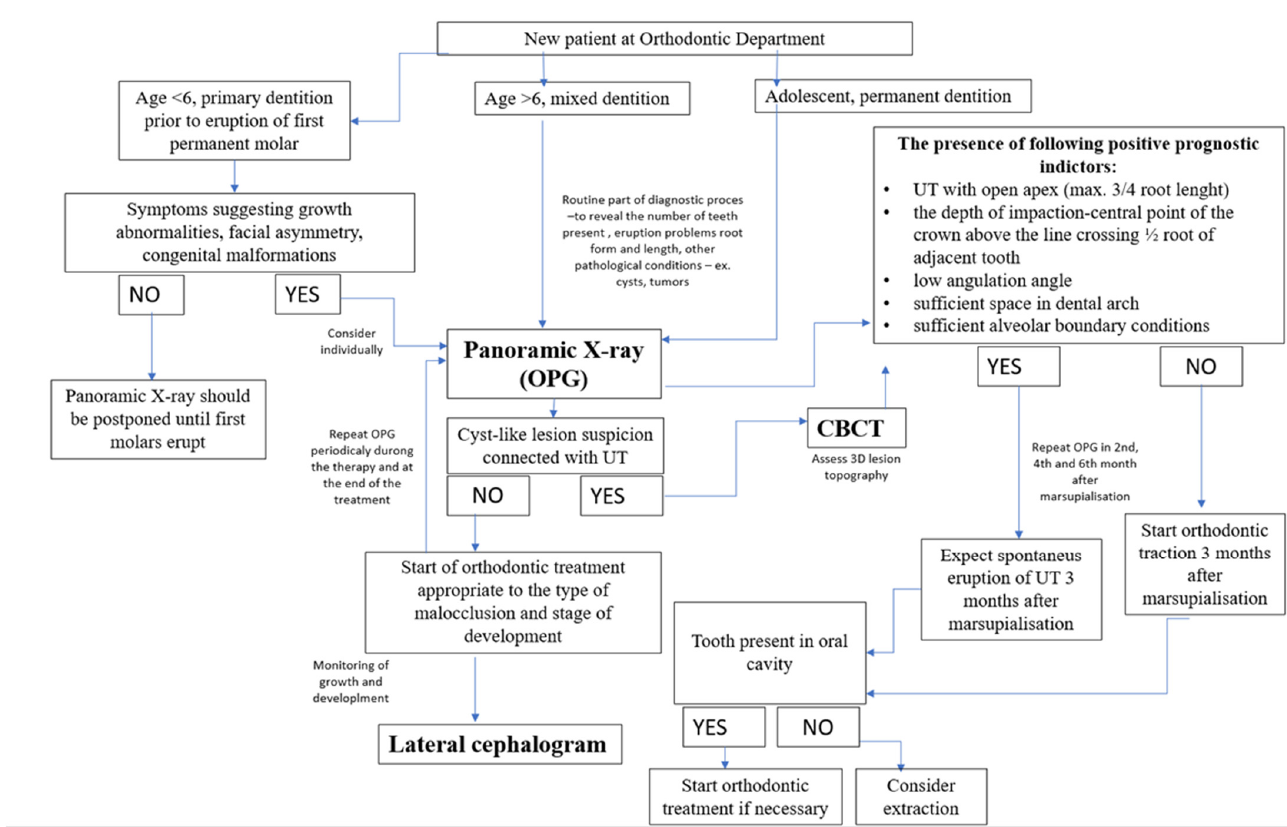
Figure 14. X-ray diagnostic algorithm in new orthodontic patient. Legend: UT—unerupted tooth. The presented case emphasizes the significance of routine orthodontic screening in